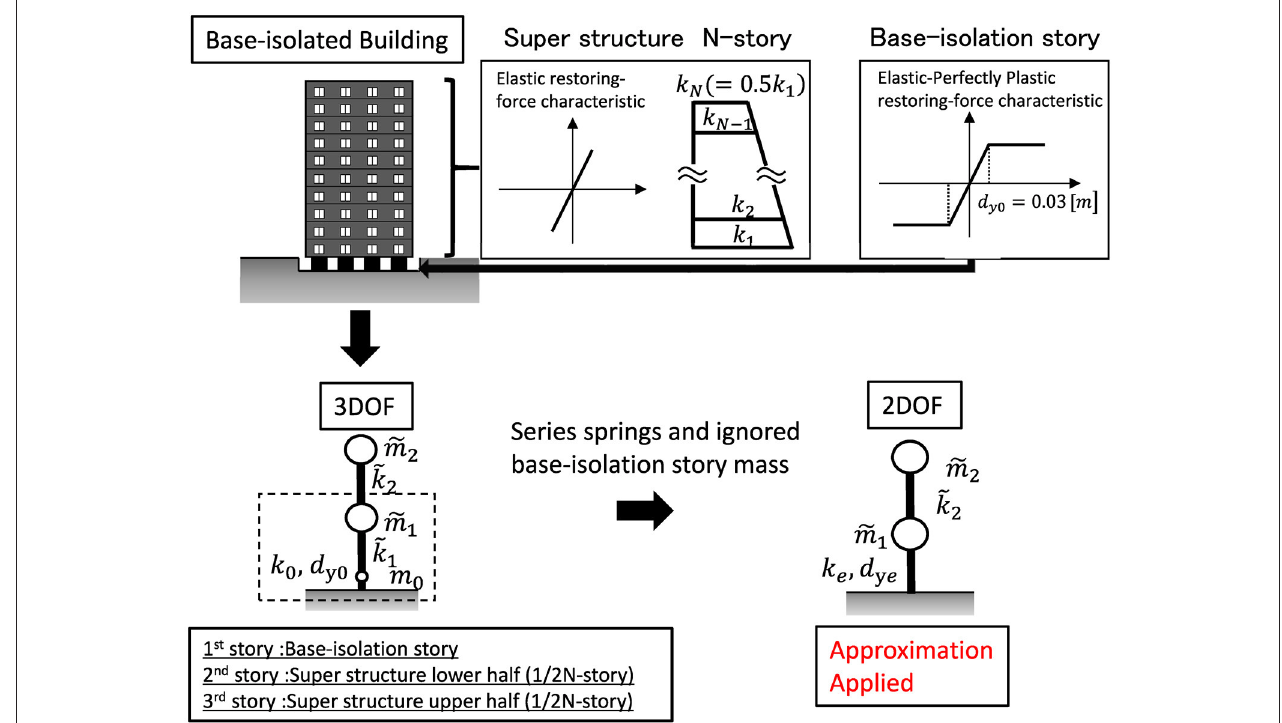
FIGURE 13 | Procedure for transforming original base-isolated buildings into 2DOF elastic-perfectly plastic system.